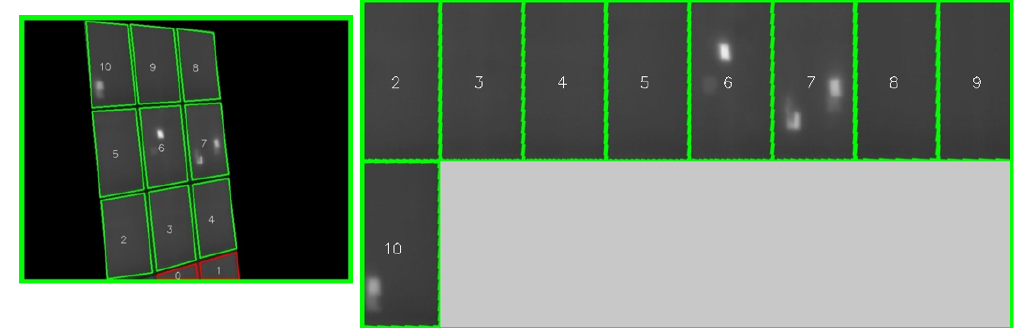
Figure 12. Perspective correction of the detected panels.